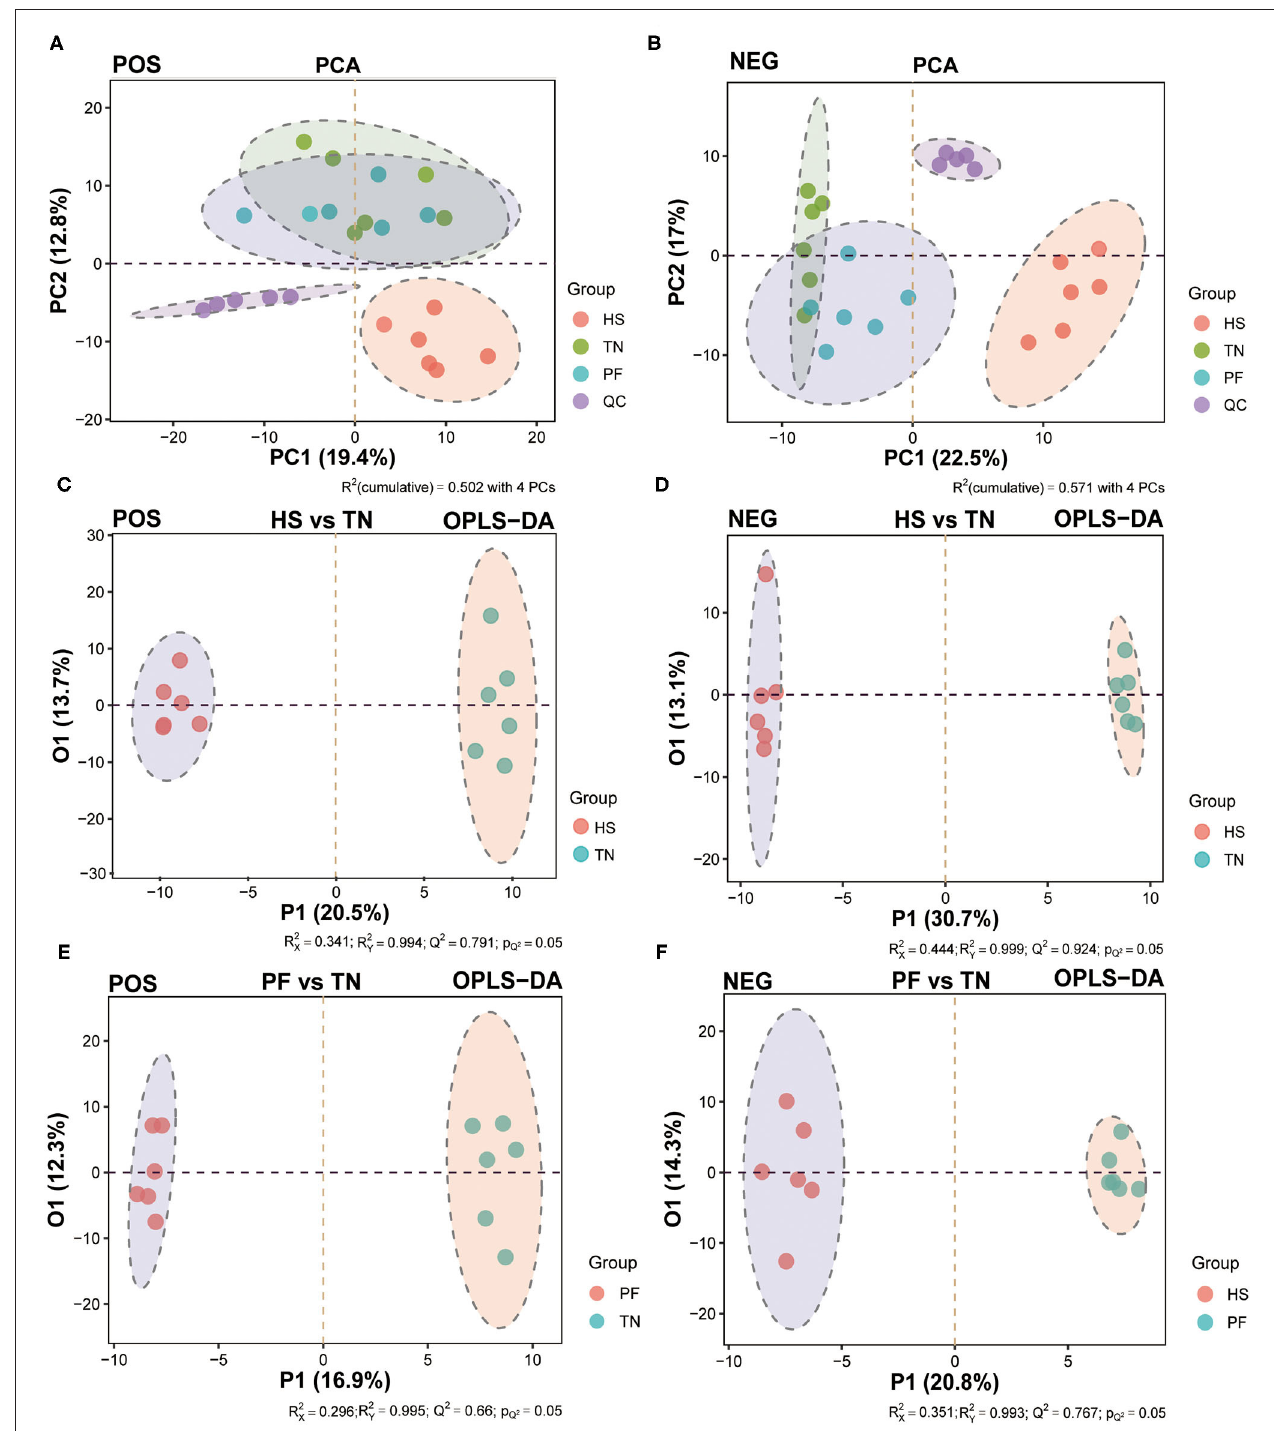
FIGURE 6 | Multivariate analysis of the untargeted UHPLC-QTOF/MS metabolomics. The PCA score plots display the variance of positive (A) and negative (B) ions among TN, PF, and HS groups. The OPLS-DA score chart of serum metabolite analyzes the variance of positive (C) and negative (D) ions between the HS and TN groups, and the variance of positive (E) and negative (F) ions between the PF and TN groups.